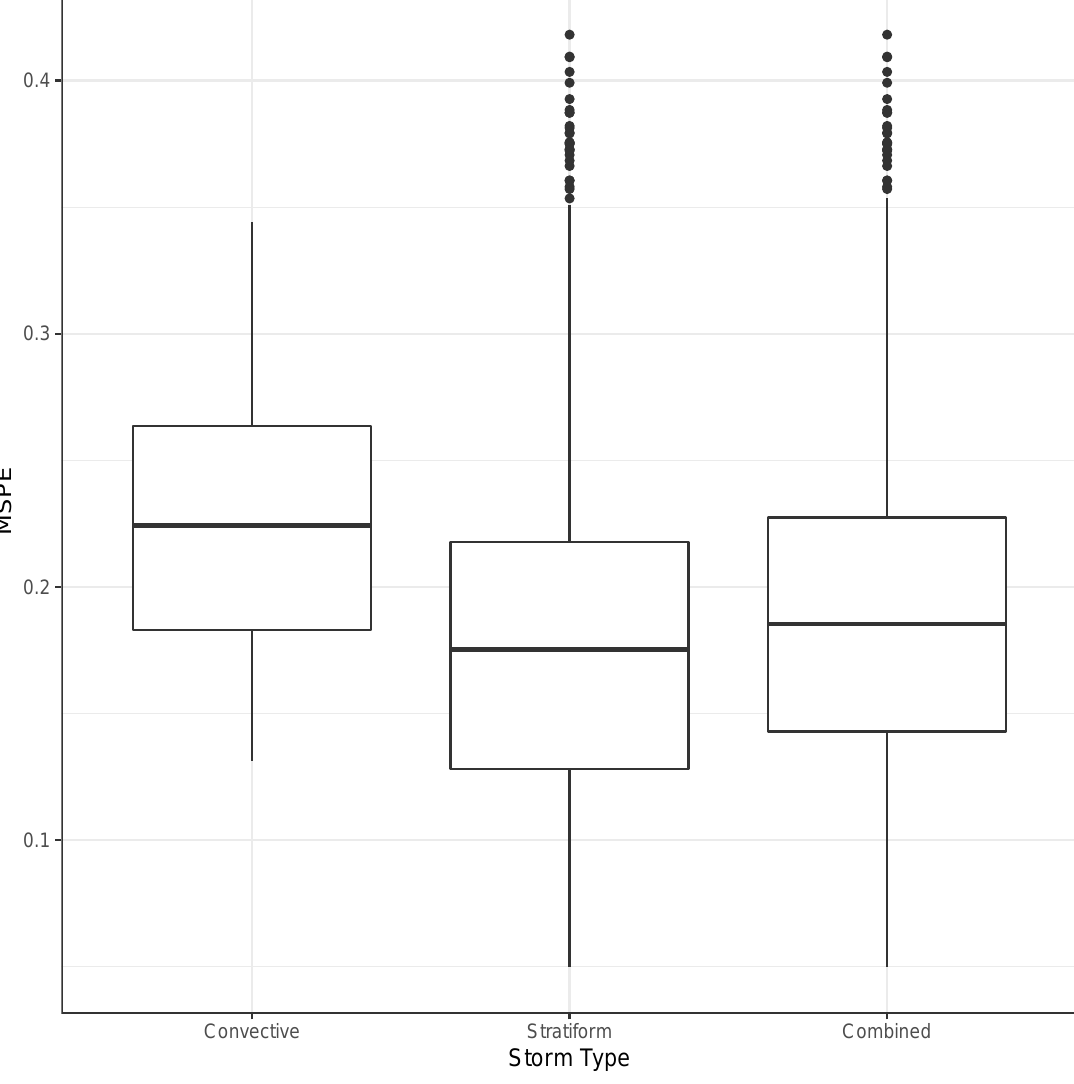
Figure 9. Boxplots of the MSPE for the three types of rain events.